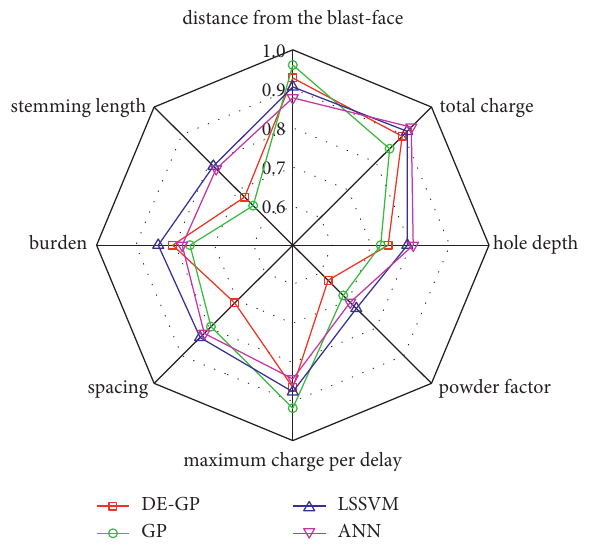
Figure 14: PPV sensitivity analysis of different prediction